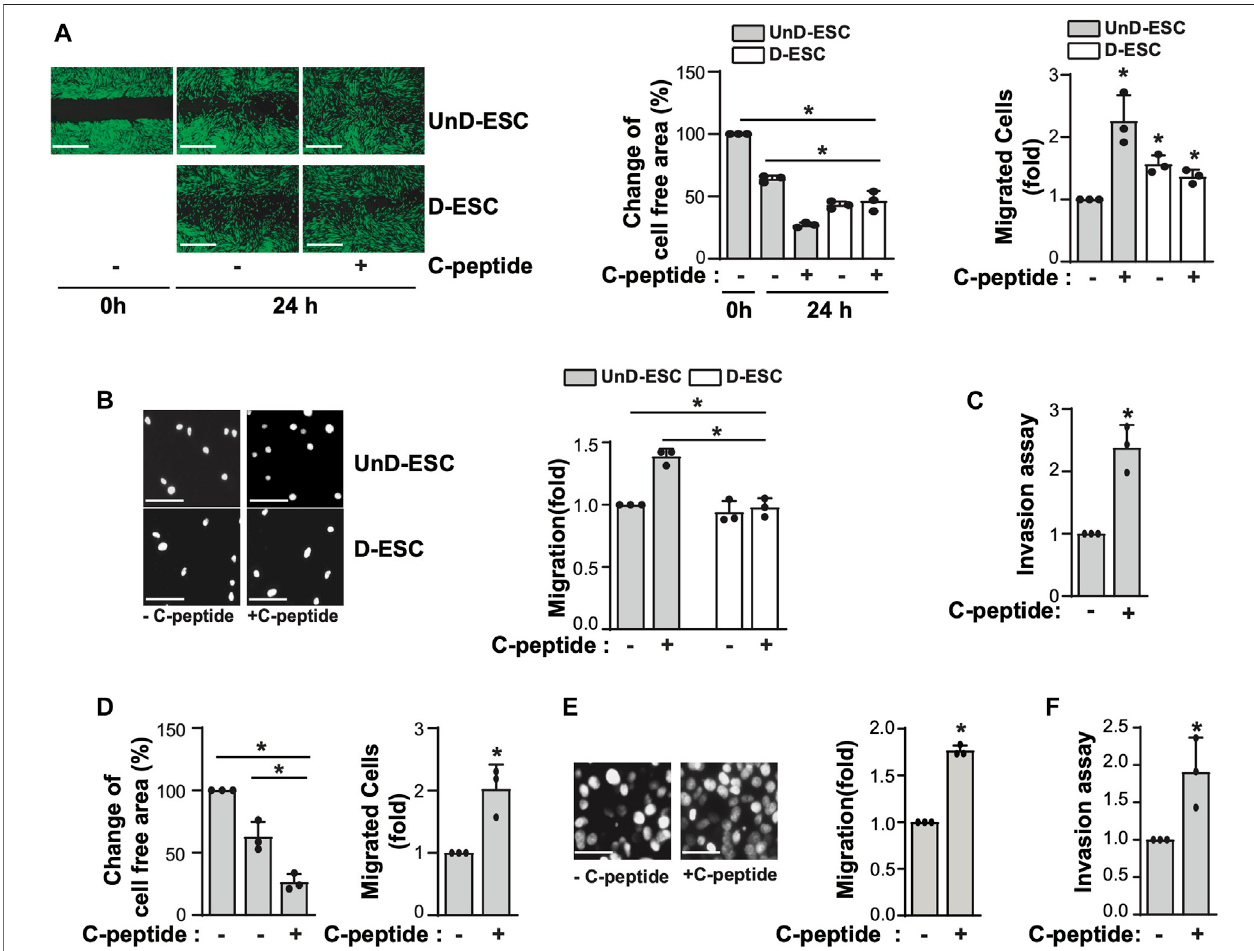
FIGURE 1 | C-peptide enhances cell migration and invasion in undecidualized human endometrial stromal cells (UnD-ESCs) and Jeg3 cells. (A – D) The isolated HESCs were used as the undecidualized HESCs (UnD-ESCs) and decidualized HESCs (D-ESCs) on day 2 after the induction of decidualization in the presence of 8-Br- cAMP. (A) UnD-ESCs or D-ESCs wereserum-starved for 18 h, wounded using a T200tip, and incubated withor without50 nM C-peptide for24 h. Then, HESCs were stainedusingtheCytoPainterCellTrackingStainingKit,andvisualizedusinganOlympusCKX53microscope(X4). (B) UnD-ESCsorD-ESCswereplatedontrans- well fi lters and 50 nM C-peptide was added to the outer chamber of each fi lter. The cells were incubated for 24 h and stained using DAPI and visualized using an OlympusCKX53microscope(X4). (C) UnD-ESCsweresplitoncollagen-coated trans-wellsandtreatedasdescribedin (B) ,followingthemanufacturer ’ sinstruction. (D) HESCs from three participants (n (cid:1) 3) were subjected to wound-healing scratch assays for 24 h, with or without 50 nM C-peptide. (E) JEG-3 cells were treated and analyzed as described in (B) . (F) JEG-3 cells were treated and processed as described in (C) . Asterisks (*) indicate signi fi cant differences ( p < 0.05) when compared to C-peptide untreated control or C-peptide treated UnD-ESCs control for 24 h. Scale bar (cid:1) 100 μ m.